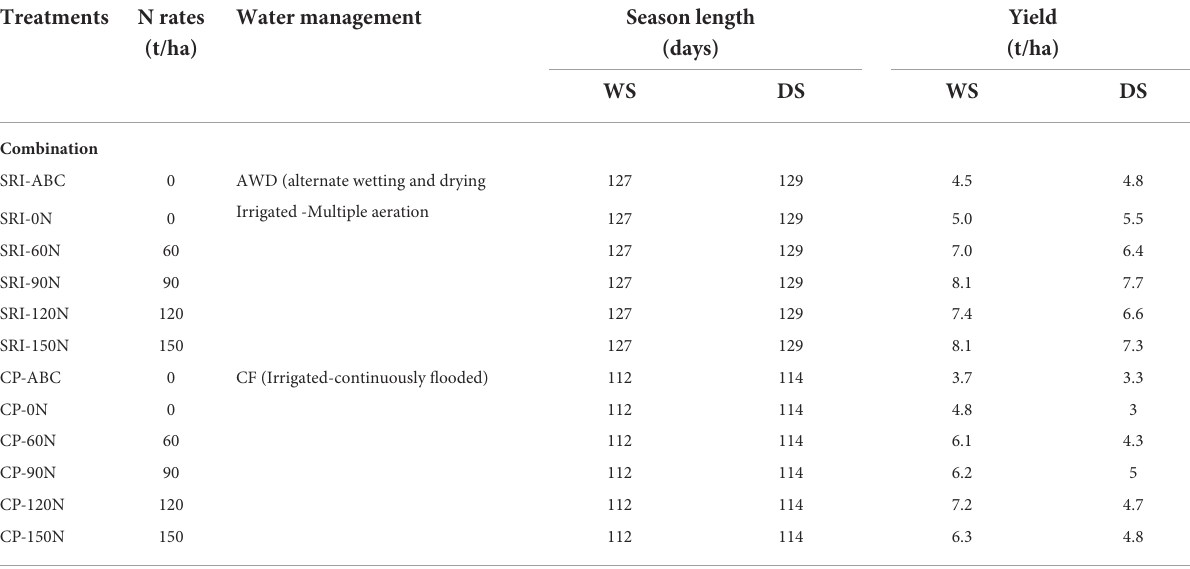
TABLE 8 Yield, season length, nitrogen rate and water management used as input values in SECTOR tool.